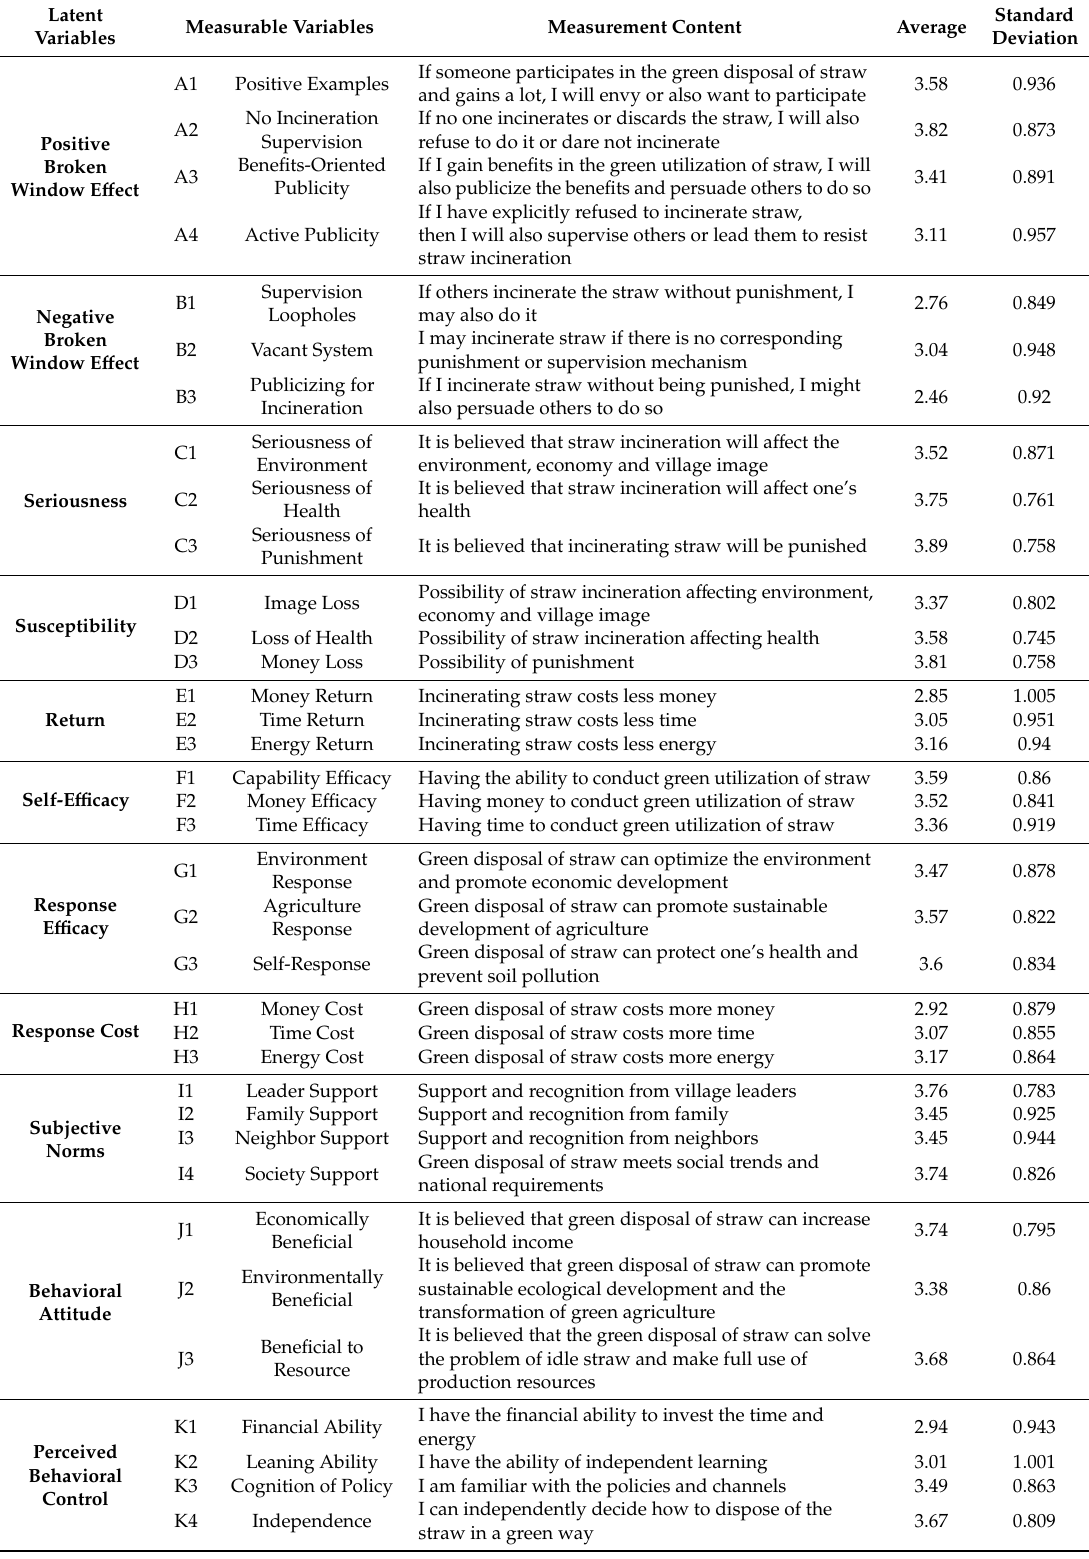
Table 1. Definition and Descriptive